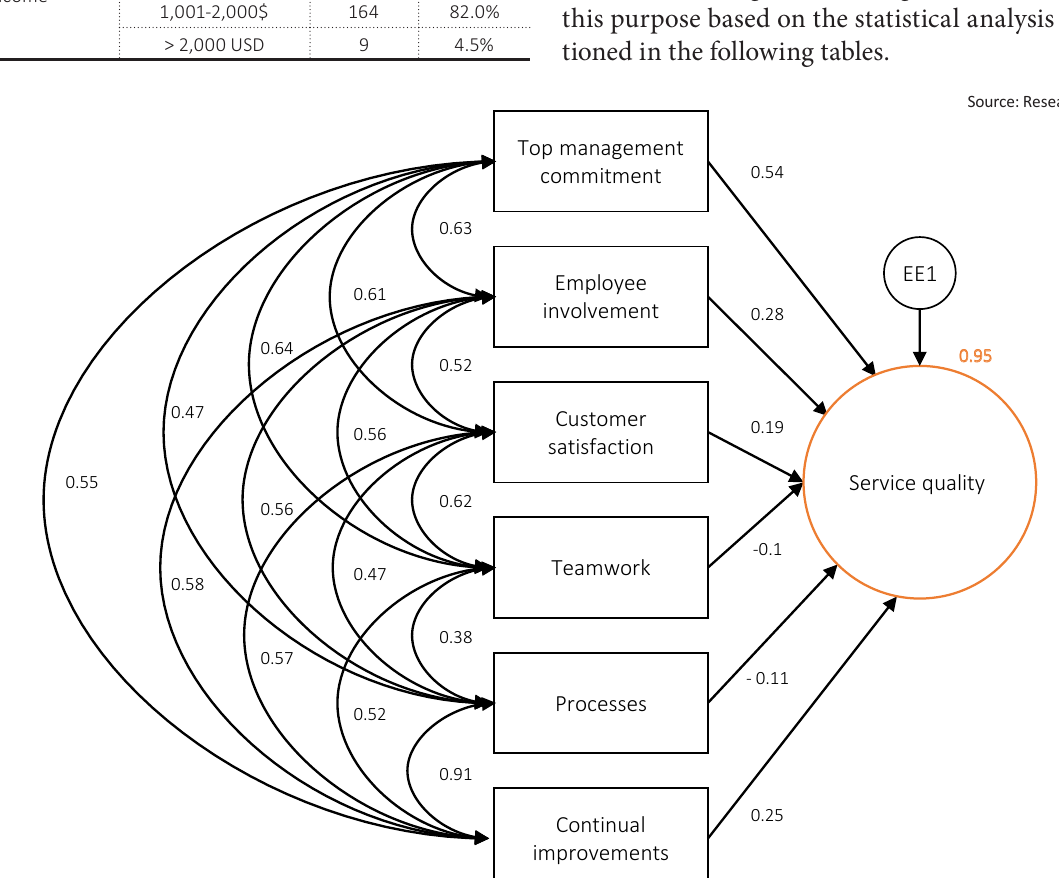
Figure 2. Conceptual model